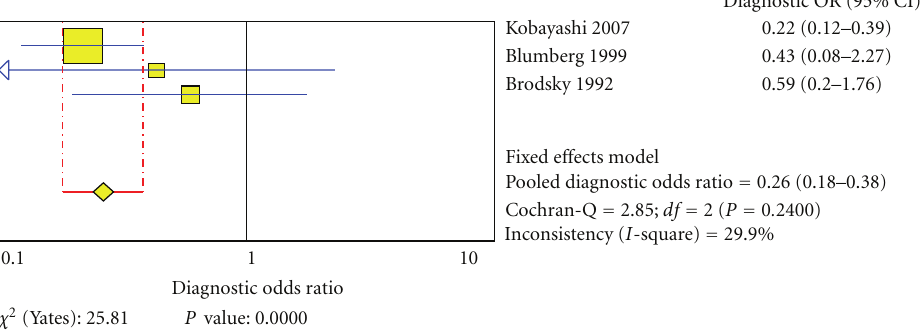
Figure 6: Risk of lymph node metastasis in lymphatic